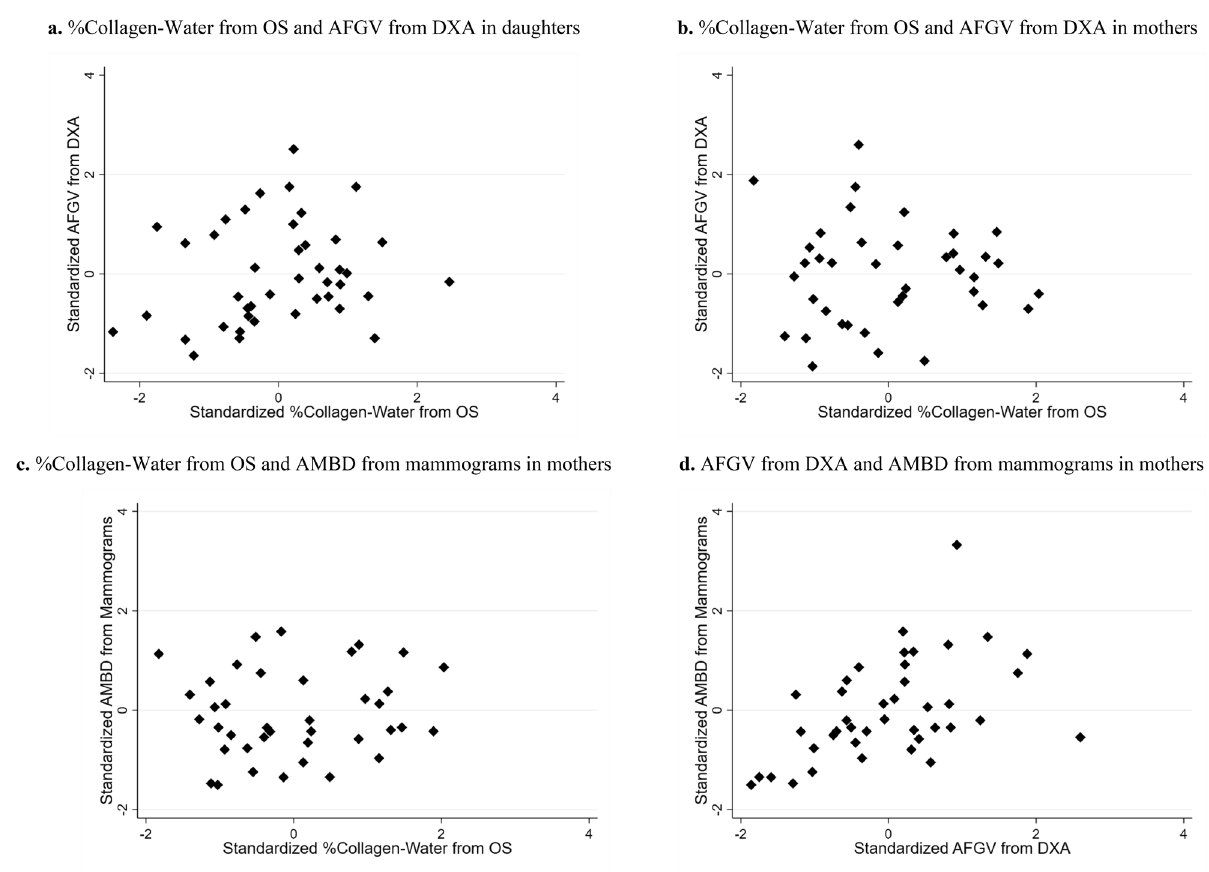
Figure 2. Scatter plots comparing absolute measures of breast density from different devices in daughters and mothers from the Growth and Obesity Study in Santiago, Chile. Percent collagen and water (%collagen- water, %C-W) from optical spectroscopy (OS), absolute fibroglandular volume (AFGV) from dual-energy X-ray absorptiometry (DXA), and absolute mammographic breast density (AMBD) from mammograms are standardized to a mean of zero and a standard deviation of one. Observed values are presented as diamonds in scatter plots.